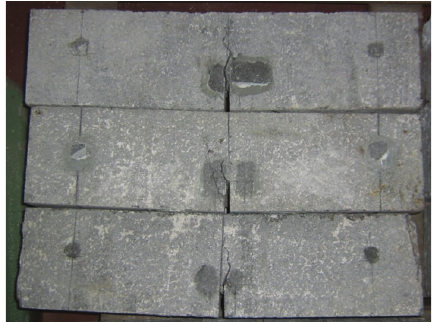
Figure 7: Post-test aspect of the notched specimens with 1% of steel fibres volume